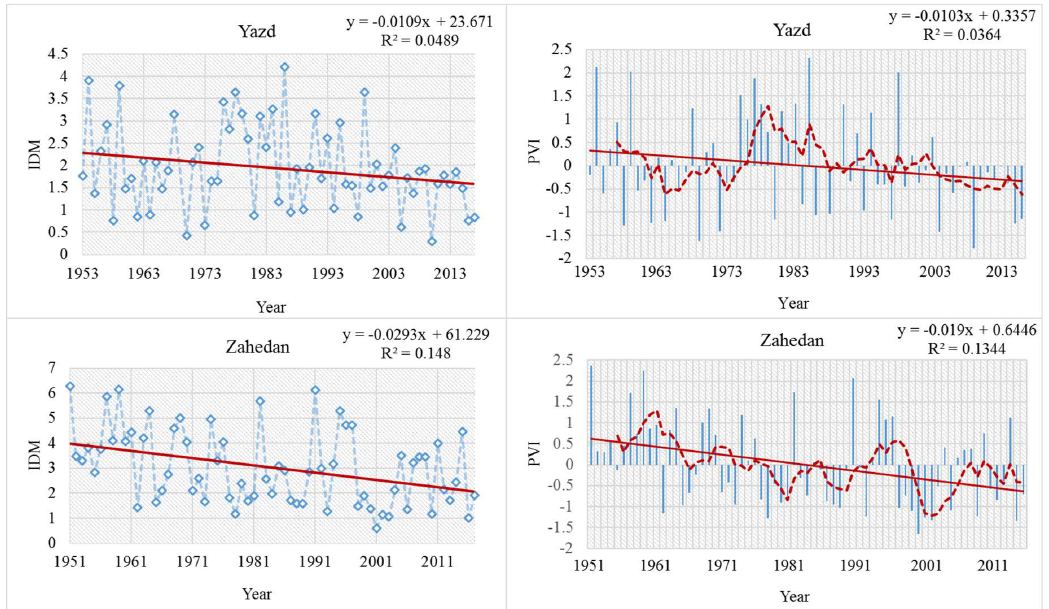
Figure 2. Annual precipitation variability indices (PVI) for the six selected synoptic stations from four different climate types. The dashed red lines ( right ) show the five-year moving average. The solid red lines ( left and right ) denote a simple regression analysis. Source: Iranian Meteorological Organization (https://irimo.ir/eng/index.php).